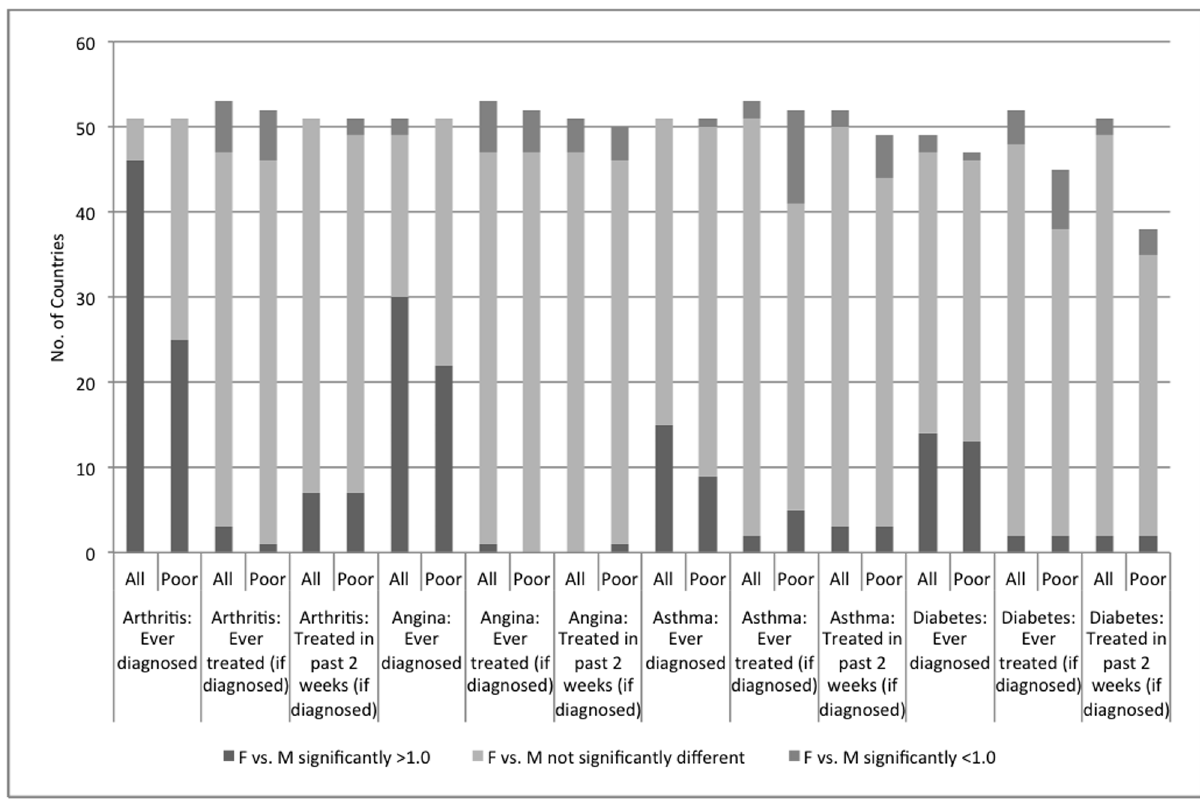
Figure 2. Chronic conditions among adults, number of countries with significant gender differences, all versus poor households. Chronic conditions (arthritis, angina, asthma, diabetes) among adults, number of countries with significant gender differences, all versus poor households.